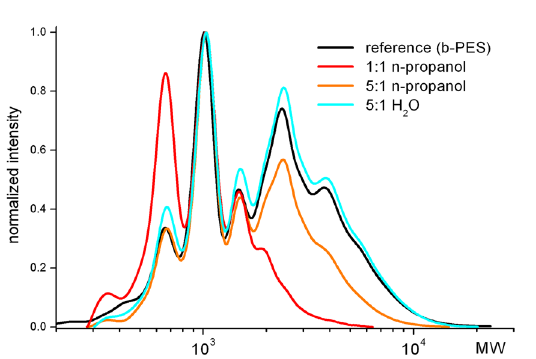
Table 1. Retrieved percentage of acetate from LDH-Ac after: the addition of BA (1 st number) as a function of stoichiometry (carboxylate to layer charge) and solvent type and after subsequent addition of matrix compounds respectively (2 nd number).